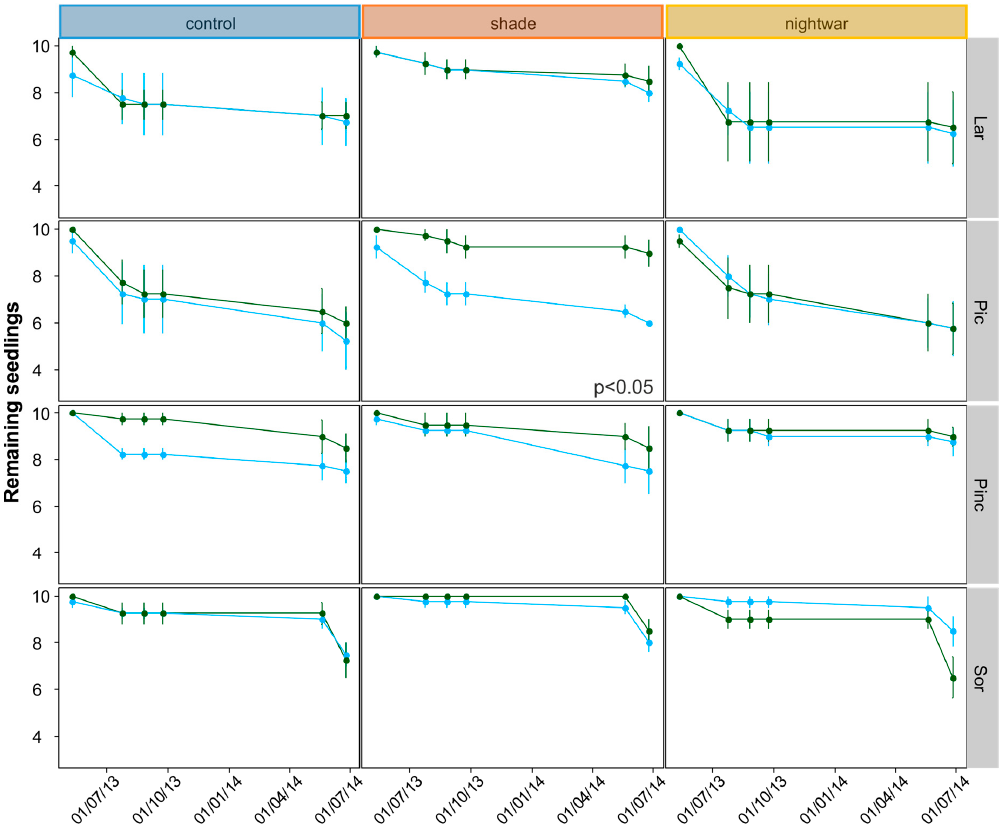
Figure 5. Seedling numbers per experimental plot remaining through time (two growing seasons) of ten per plot planted in autumn 2012 near the treeline in the French Alps. Species: Lar = Larix decidua , Pic = Picea abies , Pinc = Pinus cembra, Sor = Sorbus aucuparia . Line colors indicate the snowmelt timing treatments: early (dark green) and late (blue). Columns represent sky-exposure treatments: control (no roof), shade (shade roof during the day), and nightwar = night warming (shade roof during the night). The p value corresponds to a single significant output from pairwise comparisons (using Log-Rank test) of survival curves, showing a difference between early and late snowmelt in the shade treatment for P. abies . Shown are means and standard deviations, n = 4 plots. Measurement dates: 12